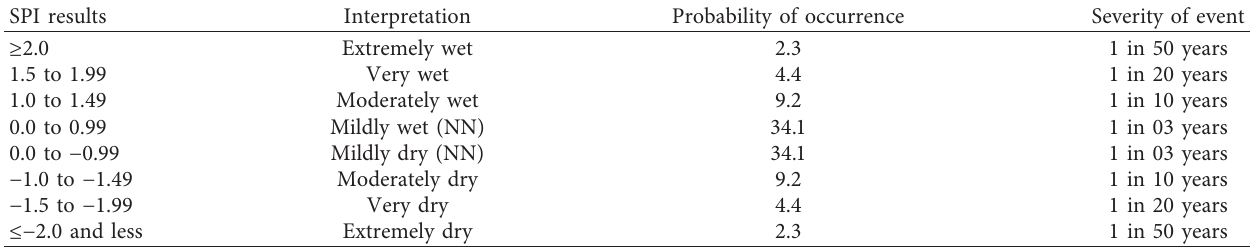
Table 2: SPI values.